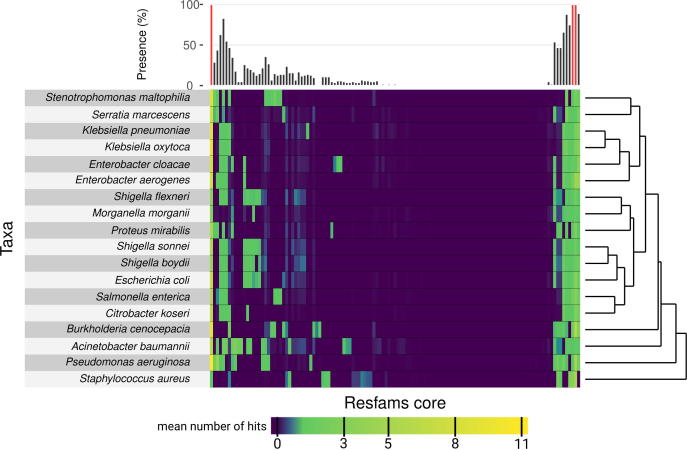
Frequency of Resfams hits per species Shown is the mean number of hits per resistance factor from the Resfams core database. The rows and columns were ordered using hierarchical clustering (Euclidean distance and average linkage). The bar plot at the top of the heatmap shows the frequency of the resistance factor across all isolates and the bars showing frequencies of at least 90% are highlighted in red.